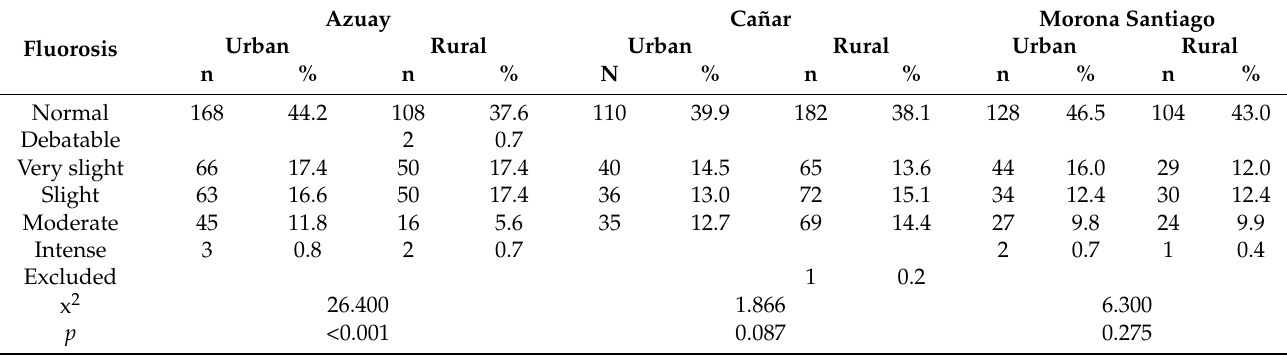
Table 2. Prevalence and distribution of DF levels by urban and rural setting.